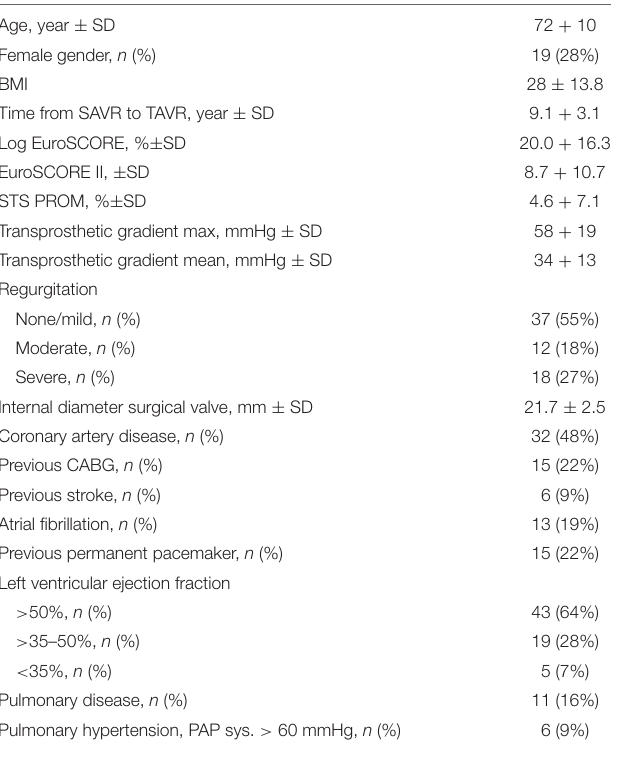
TABLE 2 | Procedural details of bioprosthetic ring fracturing attempts. Successful ring